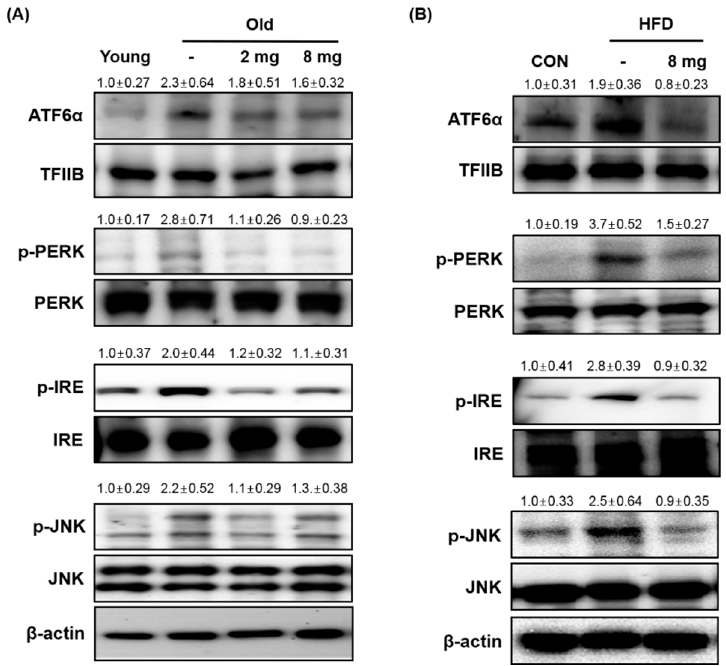
Figure 4. MLB attenuated ER stress. ( A , B ) Western blotting was performed to detect the protein level of ER stress markers ( n = 4–5 per group). Protein levels of ER stress markers decreased in the MLB-treated groups. 2 mg, MLB 2 mg/kg/day; 8 mg, MLB 8 mg/kg/day; ATF6 α , activating transcription